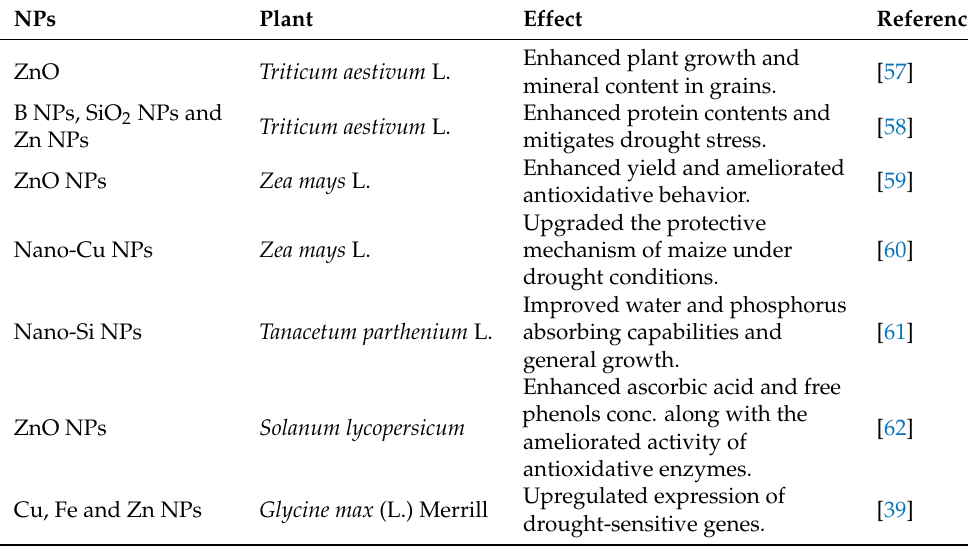
Table 1. Impact of NPs on plants under drought